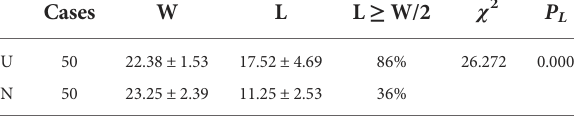
TABLE 5 Comparison of the accuracy of the two groups.